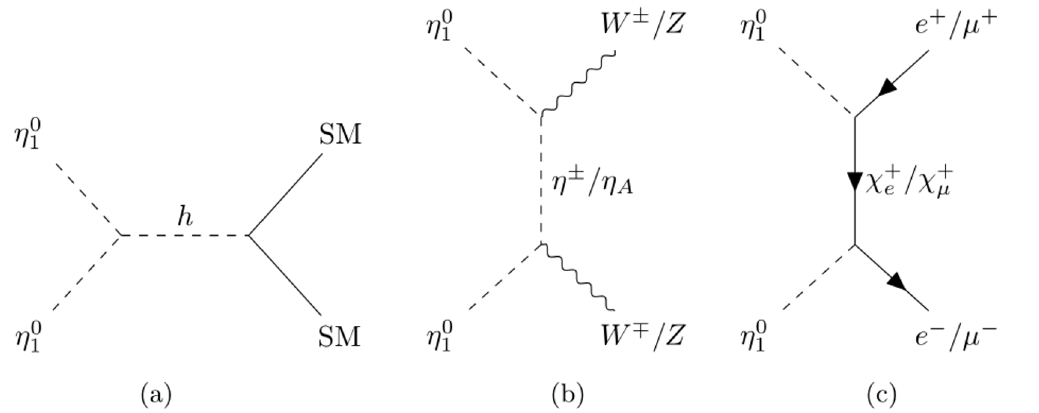
Figure 4 . Important diagrams that contribute to the DM annihilation into the SM